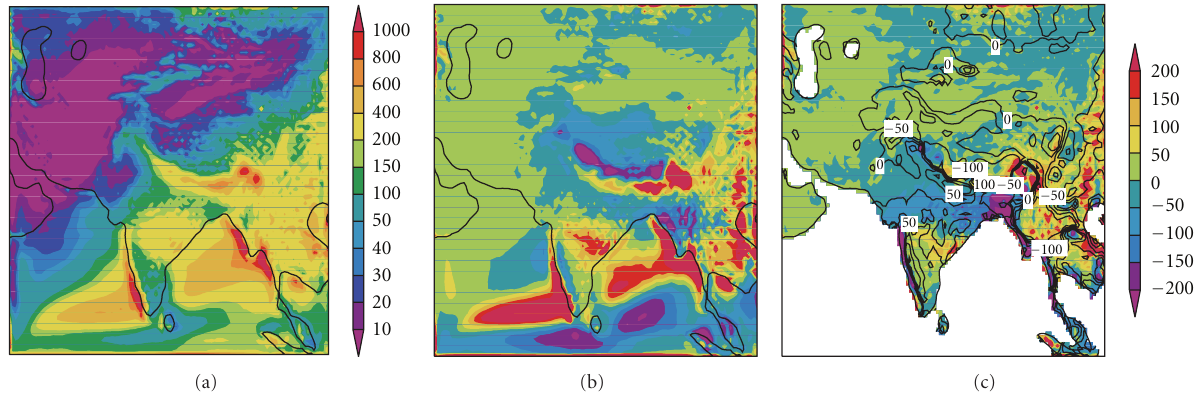
Figure 7: Precipitation (mm; shaded) for HIRHAM (a), the di ff erence “HIRHAM-ERA40” (b), and the di ff erences “HIRHAM-GPCC4” ((c); shaded) and “GPCC4-ERA40” ((c); contour lines); summer monsoon (JJAS)